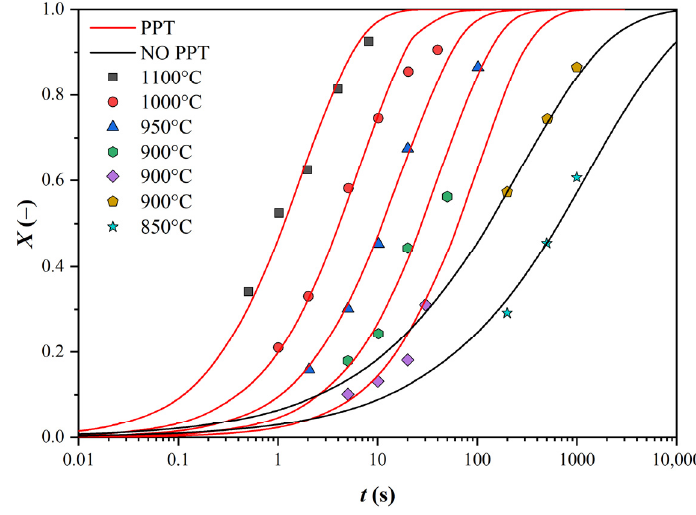
Figure 2. Plotting the experimental data with S-curves of the original data (see Figure 1).